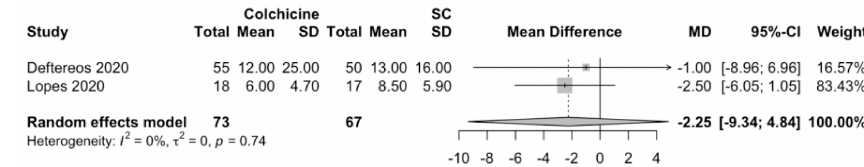
Figure 3. Forest plot of secondary outcome: length of hospitalization (in